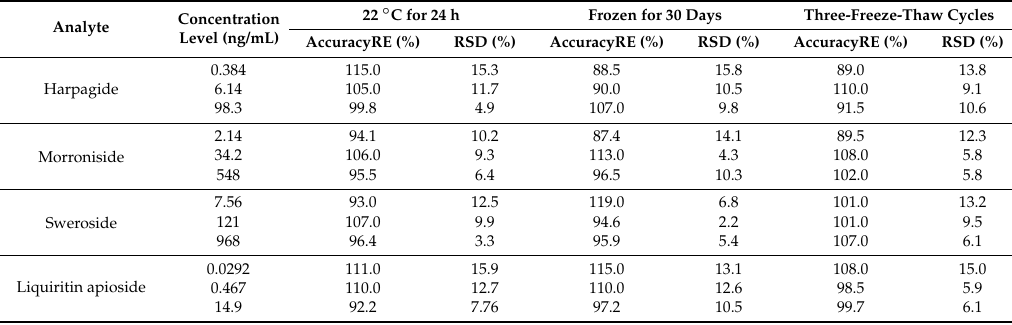
Table 6. Stability data for the twenty-five analytes ( n =